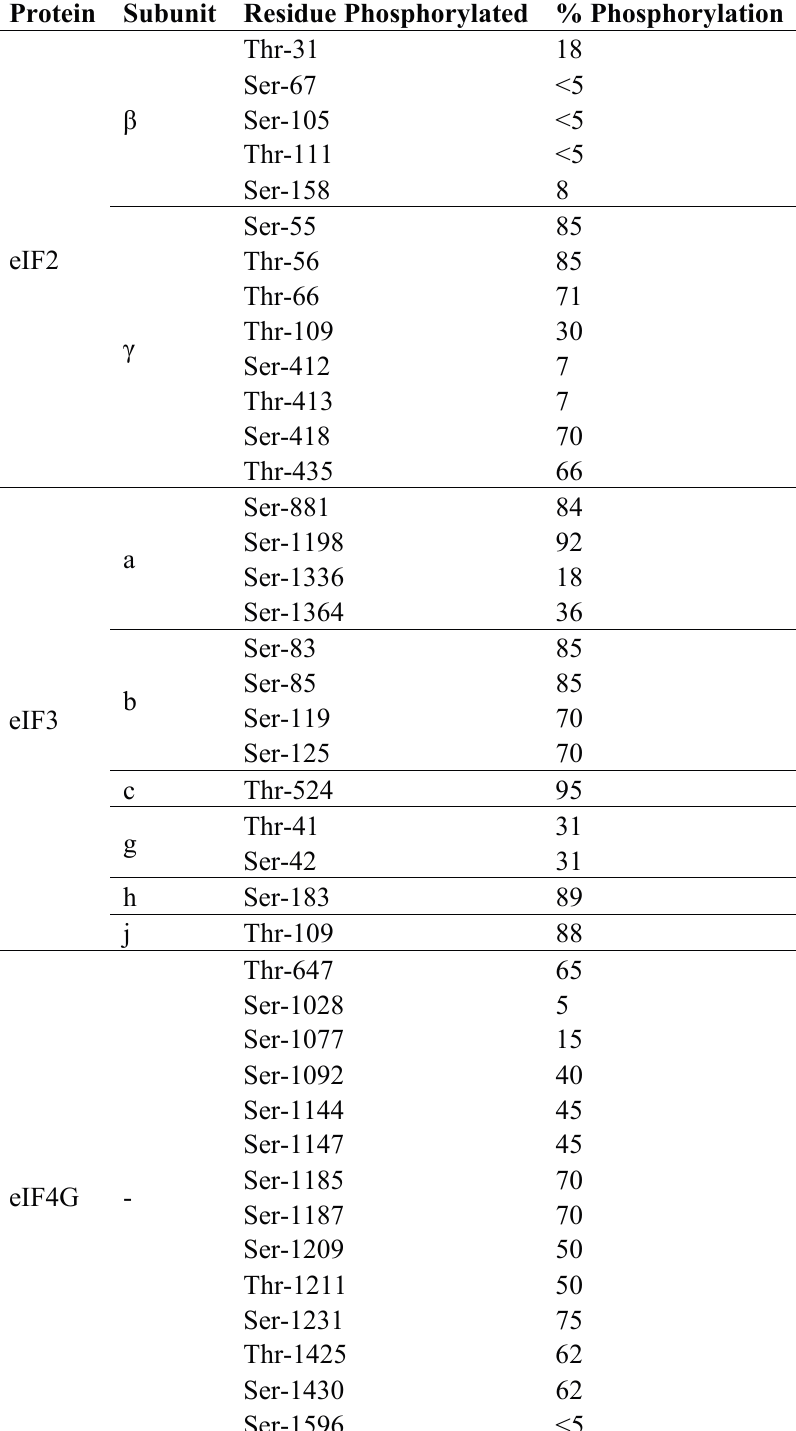
Table 1. Three of the factors, eIF2, eIF3, and eIF4G were analyzed as to their quantification of phosphorylation levels within log phase grown HeLa cells. Percentages of the phosphosites are